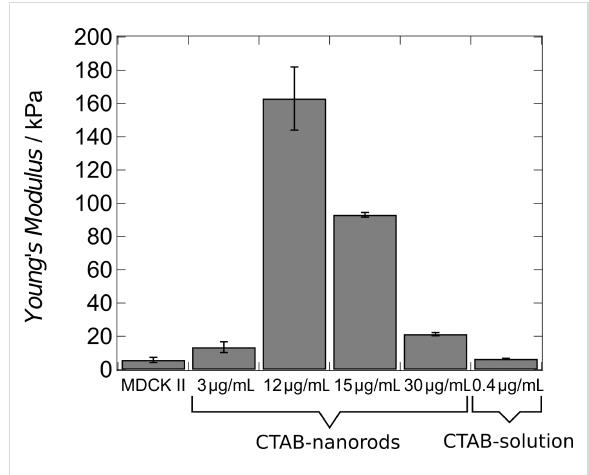
Figure 5: Young’s moduli of MDCK II cells treated with different concentrations of gold nanorods and CTAB solution.